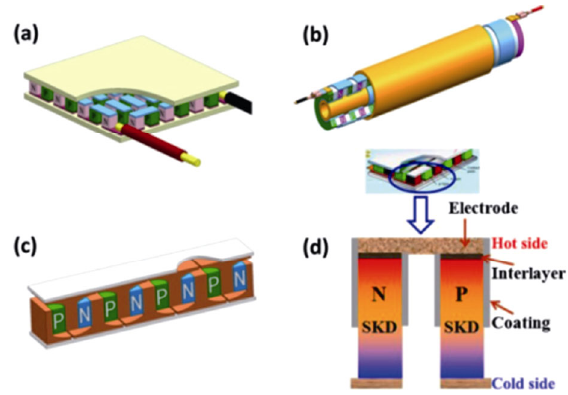
Fig. 17 Schematic diagrams of (a) П -shaped, (b) tube-shaped, and (c) Y-shaped TE module. (d) Schematic diagram of a typical П -shaped skutterudite-based TE uni-couple. Reproduced with permission from Ref. [223], © WILEY-VCH Verlag GmbH & Co. KGaA, Weinheim